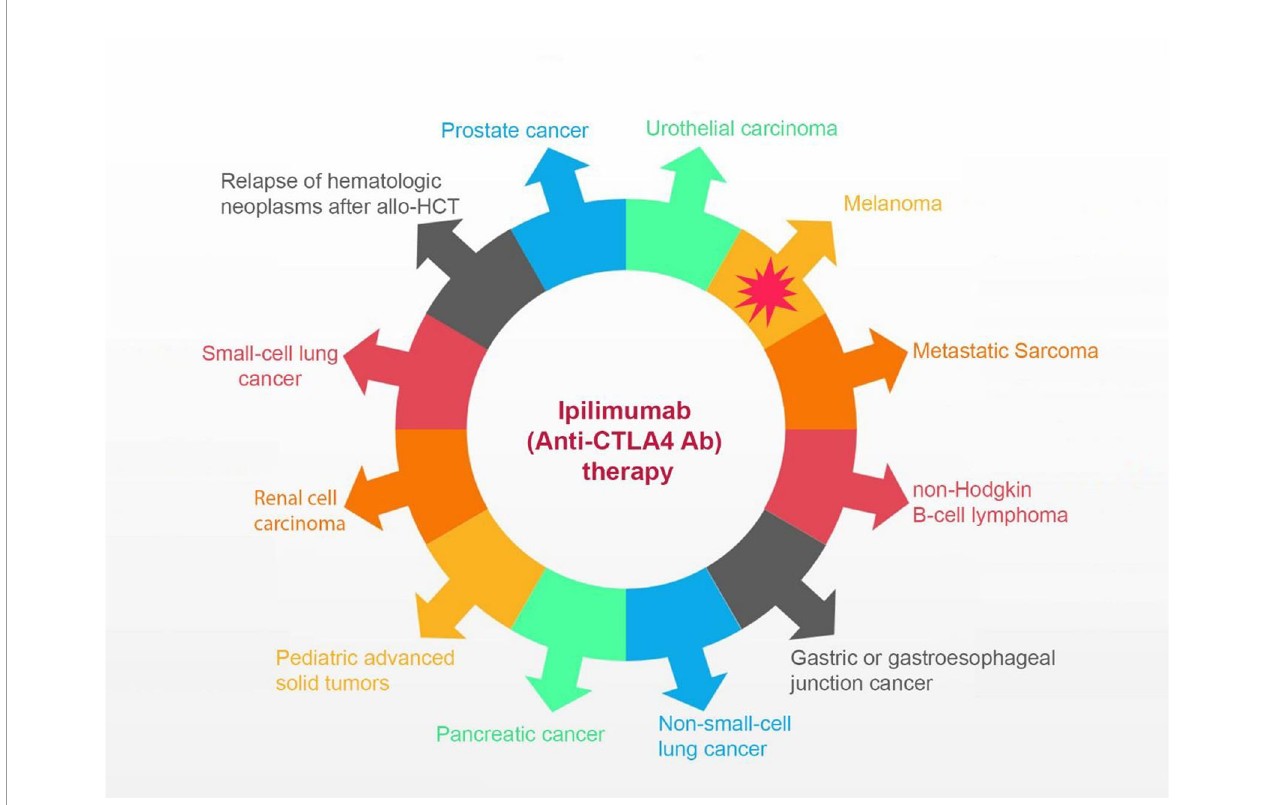
FIGURE 1 | The spectrum of activity of ipilimumab in melanoma and non-melanoma